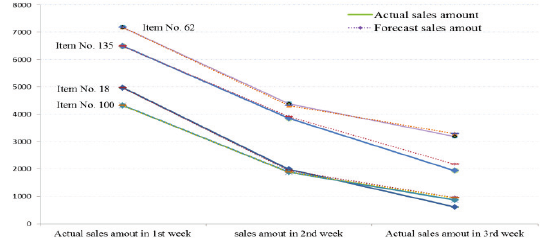
Table. 5. Accuracy analysis of the verification process.